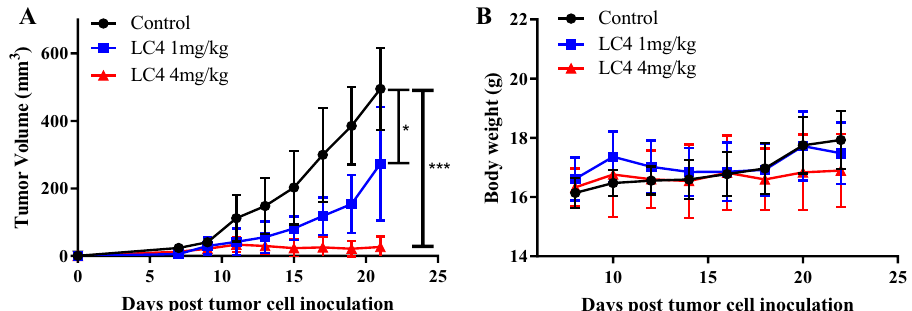
Fig. 5 LC4 could significantly inhibit CT26 tumour growth in vivo . BALB/c mice were subcutaneously injected with 2 × 10 5 syngeneic CT26 cells to establish colorectal cancer xenograft model. The mice were divided into control group, LC4 (1 mg / kg) group and LC4 (4 mg / kg) group when the tumor grew to 40–80 mm. 3 , peritumoral administration for 14 days. Statistical graph of A tumor volumes and B body weight of LC4 (1 mg / kg) group, LC4 (4 mg / kg) group and control group. Data are expressed as the mean ± SD (n = 5) and statistical signifi- cance between groups was determined by Student’s t test: *p < 0.05, ***p <